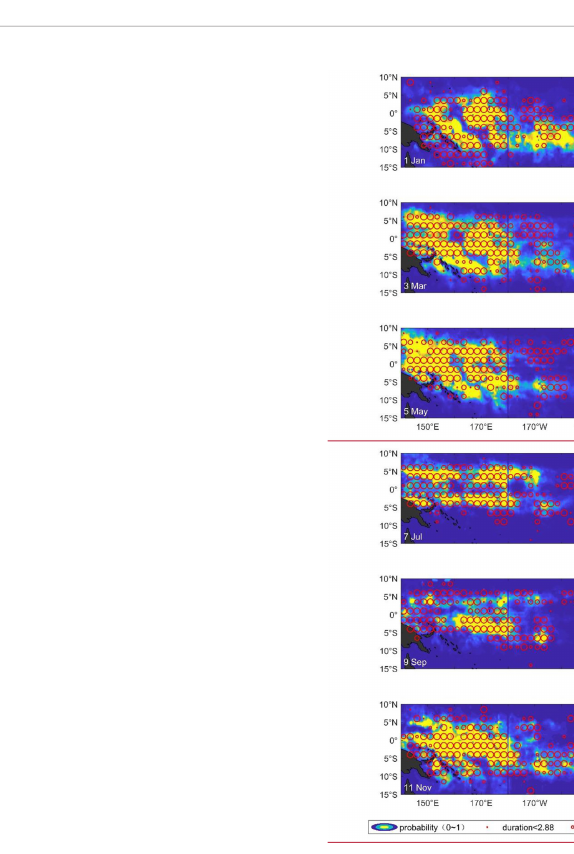
FIGURE 3 | Fishing effort superimposed